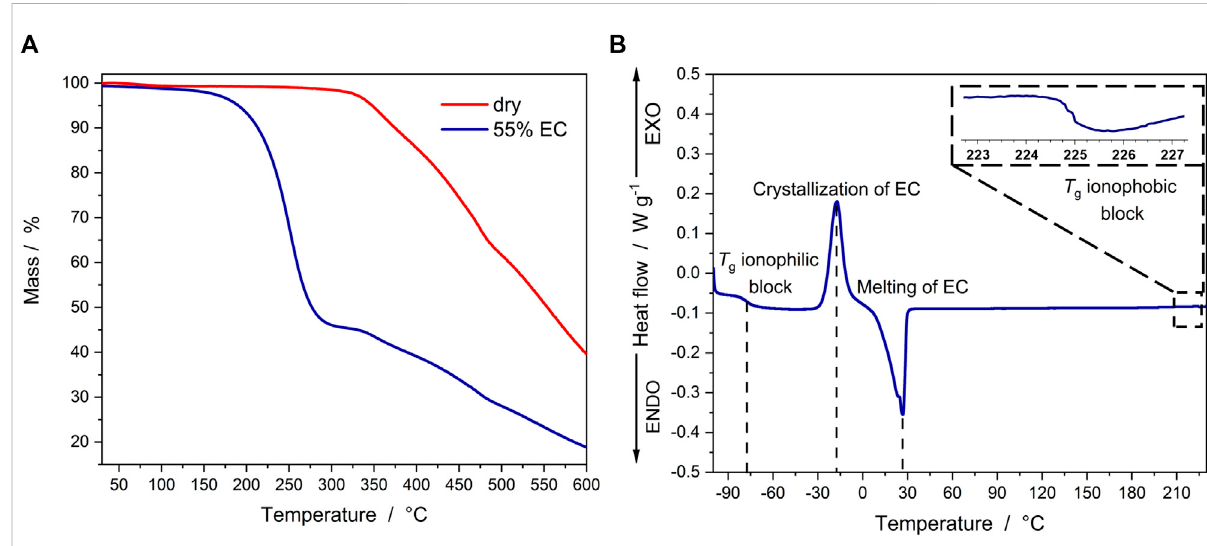
FIGURE 2 (A) TGAdatarecordedforthesulfur-dopedSIC-BCEwithoutEC(red)andswollenwith55%EC(blue). (B) DSCcurveoftheSIC-BCEmembrane swollen with 55%